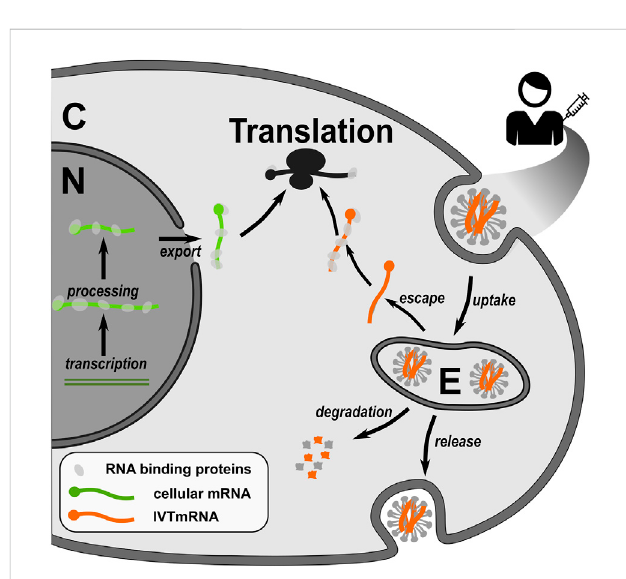
Native endogenous transcripts and IVTmRNAs have different genesis pathways which determine differences in translational ef fi ciency. Native transcripts engage with the translational machinery followingnuclearprocessingandexport,inaprotein-boundmRNP state where mRNP composition is controlled by the preceding processing steps. IVTmRNAs enter cells through the endosomal pathway, from which they escape inef fi ciently. In how far IVTmRNAs are able to form functional mRNPs is unknown. C, cytoplasm, N, nucleus, E,